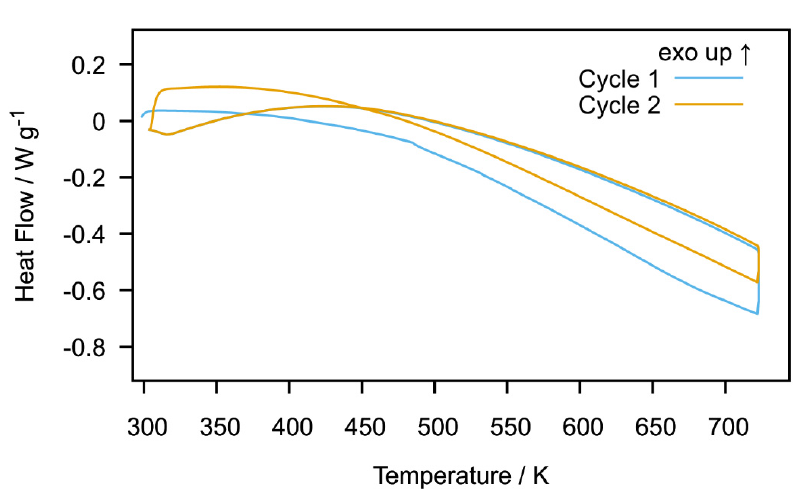
Figure A3. Differential scanning calorimetry (DSC) of ordered FePd 3 at 5.0 MPa hydrogen pressure.